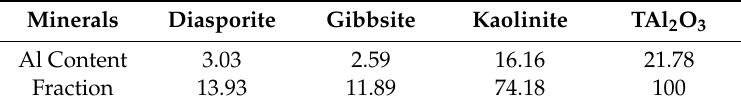
Table 3. Distributions of aluminum in mineral phases of the HAIO (wt. %). Minerals